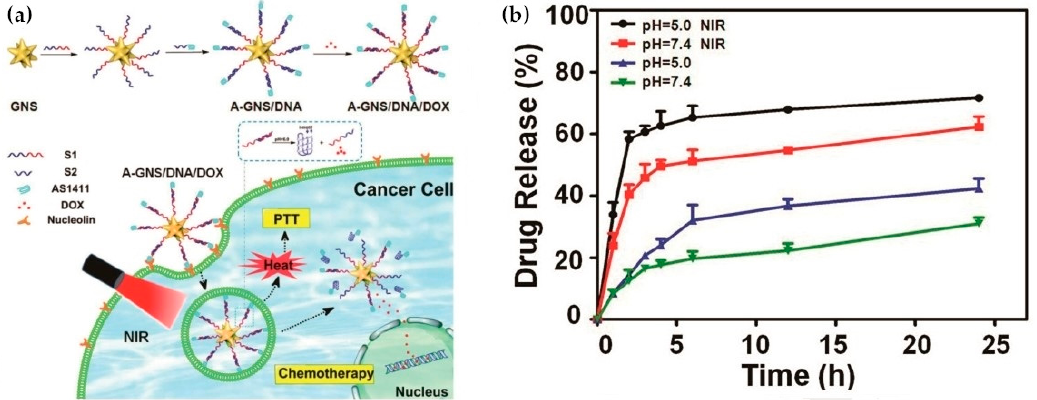
Figure 10. ( a ) Schematic illustration of NIR/pH dual stimuli-responsive nanodrug carrier (A-GNS/DNA/DOX) for chemical/PTT combination therapy for cancer. ( b ) Cumulative DOX release from A-GNS/DNA/DOX in the presence or absence of NIR and at different pH values. Reproduced with permission from the publisher of corresponding reference [206].